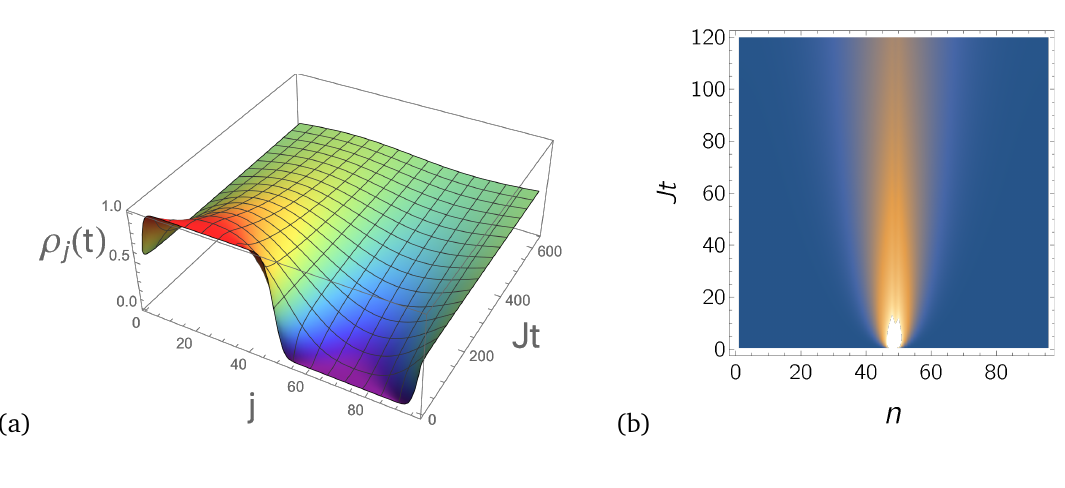
( t ) for the uncorrelated domain-wall initial state (101) Figure 5: (a) Density ρ j as a function of j and time on a ring of L = 96 sites. (b) Connected correlator ( L + 1, n , t ) for the same g − , c 2